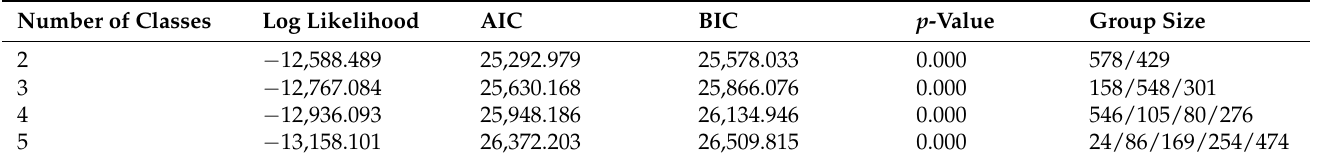
Table 4. LCA fit statistics.